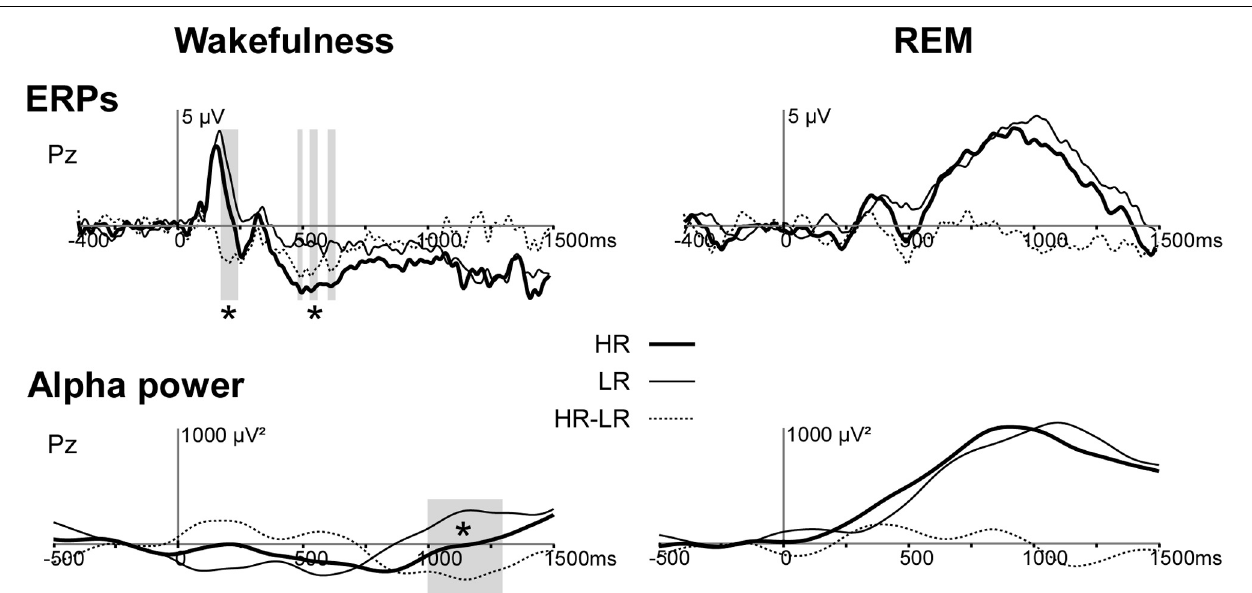
FIGURE 2 | Responses (ERPs and alpha power) to first-names in HR and LR during wakefulness and REM sleep at electrode Pz. Upper panel. ERPs to first names (Eichenlaub et al., 2013). Lower panel. Time profiles of TF power in the 8–12Hz frequency band for HR (bold continuous line), LR